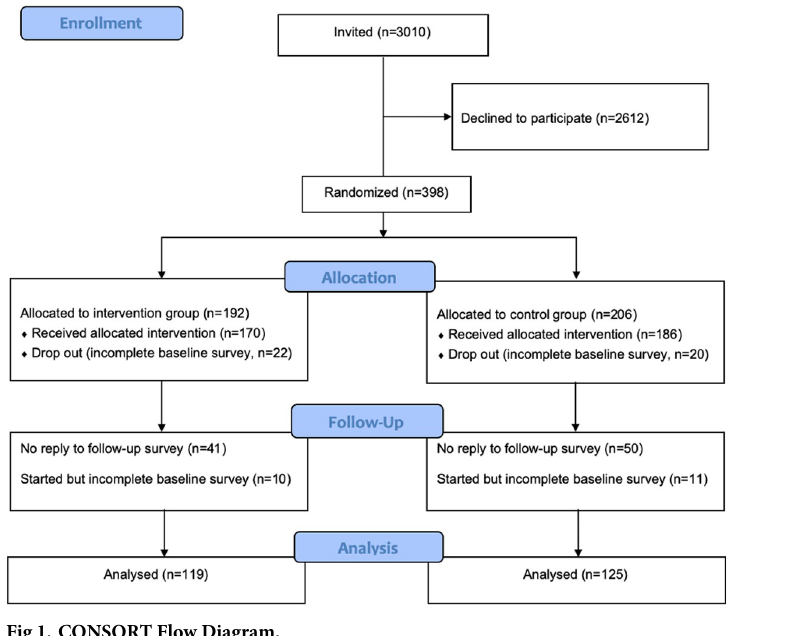
Fig 1. CONSORT Flow